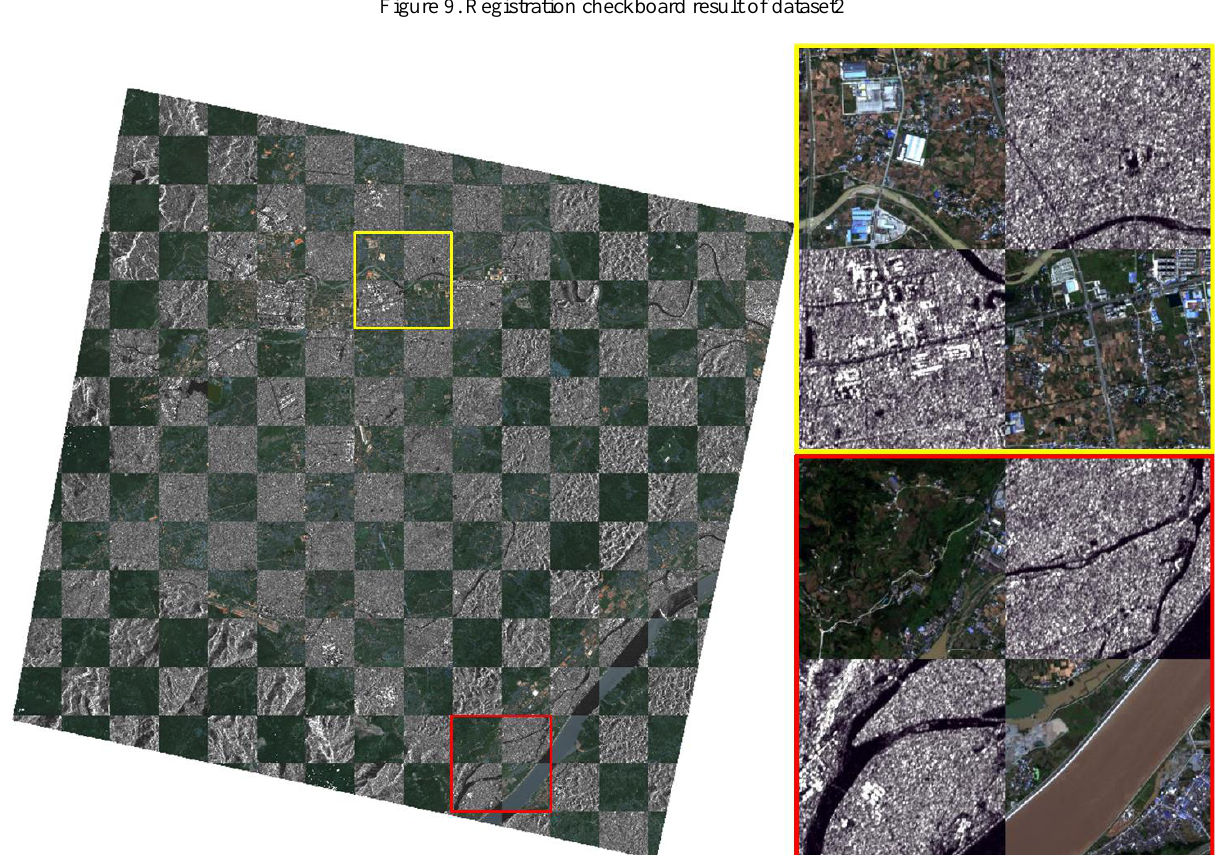
Figure 10. Registration checkboard result of